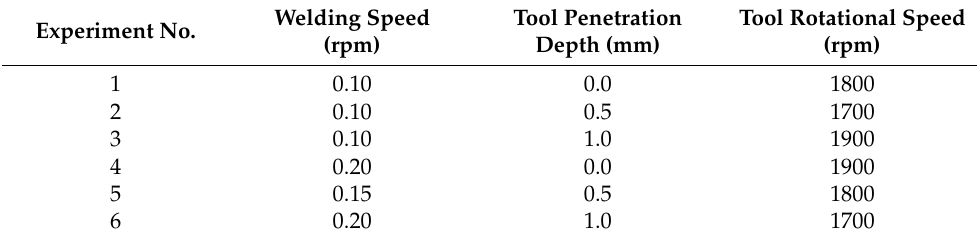
Table 2. Welding parameters for experiment.